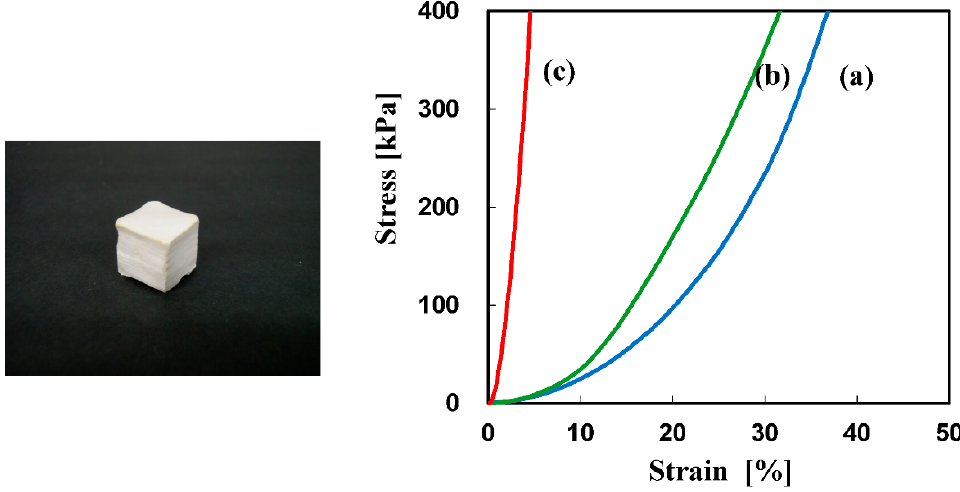
Figure 3. SEM images of AM4-HDA porous polymers Case II (feed molar ratio of AM4/HDA: 1/1), concentration and temperature ( a ) II-25w-40d, ( b ) II-25w-60d, ( c ) II-25w-80d, and ( d ) II-30w-40d.